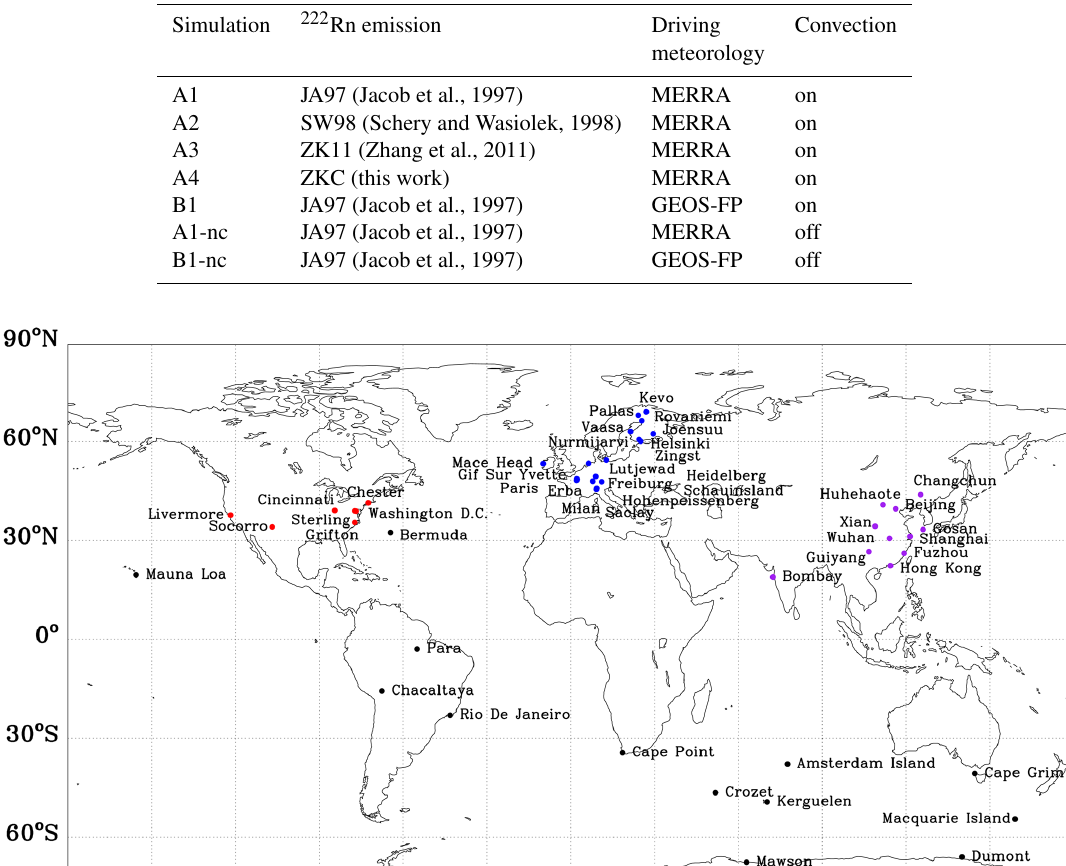
Table 2. Configurations of GEOS-Chem simulations (v11-01f, 2 ◦ × 2.5 ◦ ) used in this work.